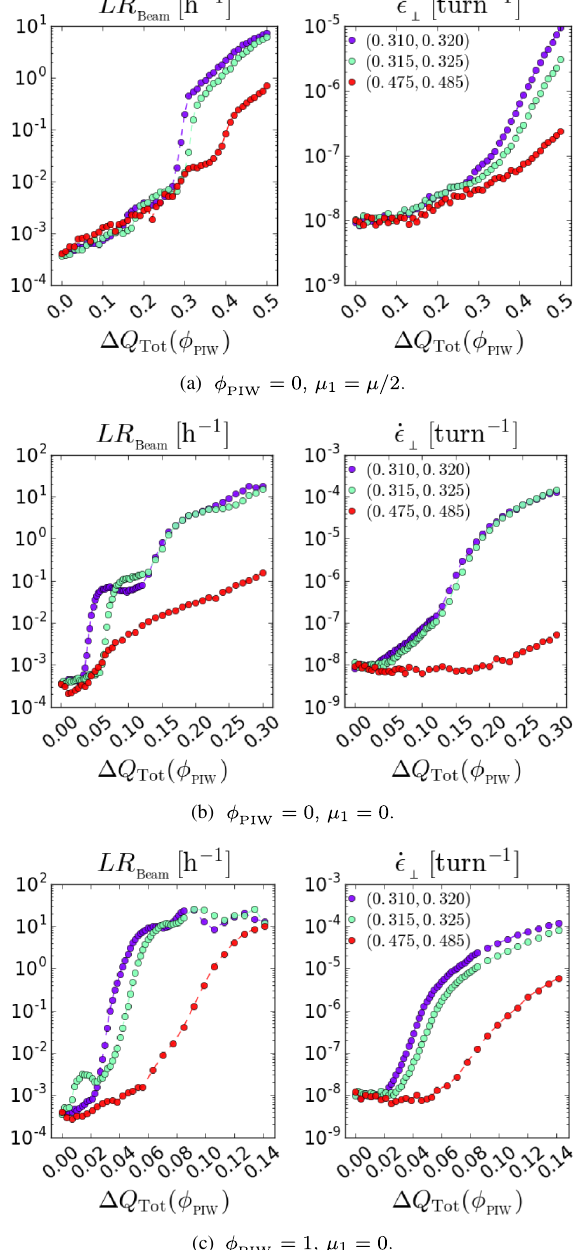
FIG. 22. Beam quality reduction for increasing beam-beam parameter, ξ , until a threshold is found. Simulations are run for Tot a large chromaticity, Q 0 ¼ 15 , and a significant hourglass effect, β (cid:1) 12 cm, changing the crossing angle, intermediate phase q ¼ advance and working point. The outputs are presented as ϕ functions of Δ Q calculated by Eq. Tot ð PIW Þ